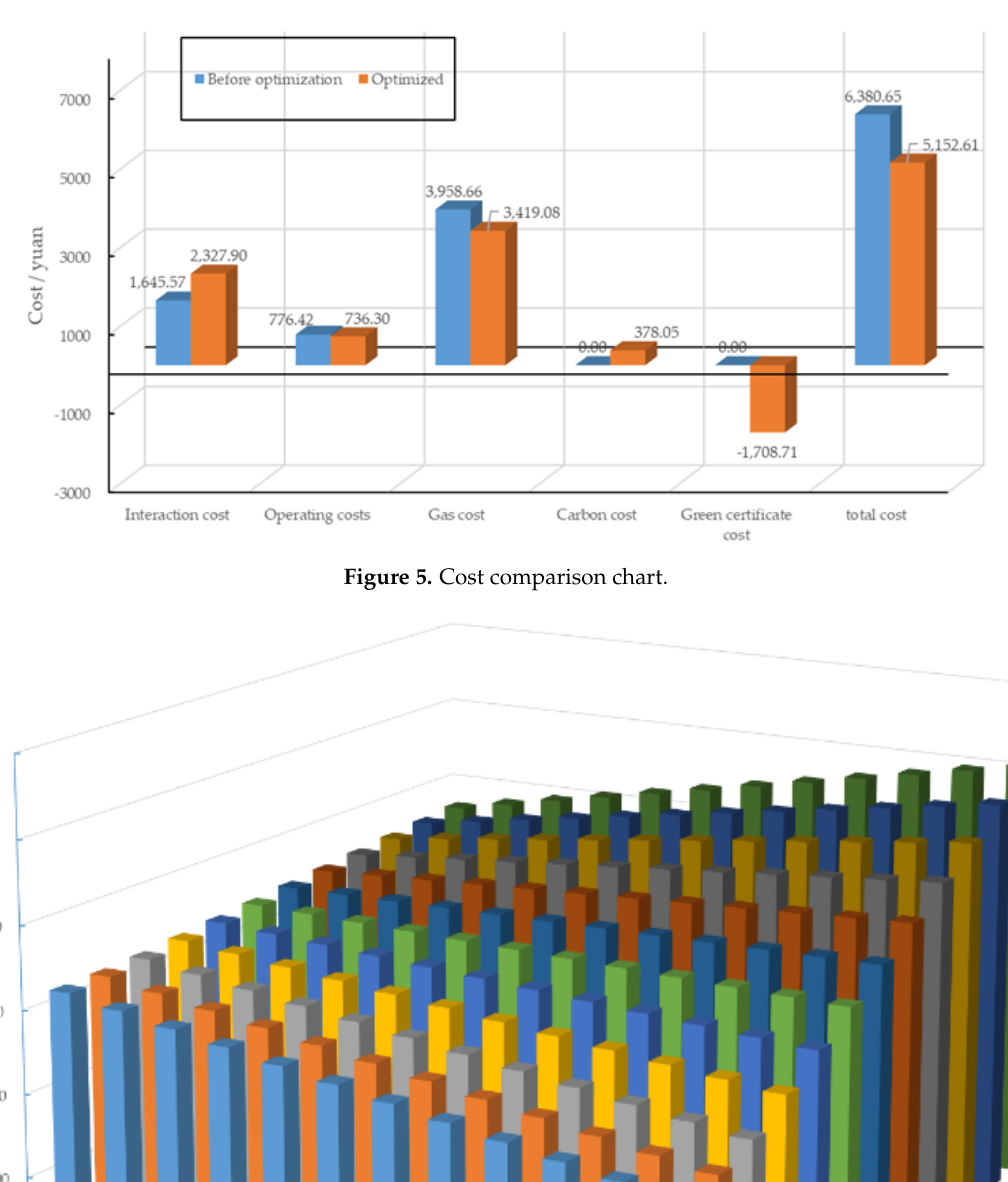
Table 3. Offset of CCER.